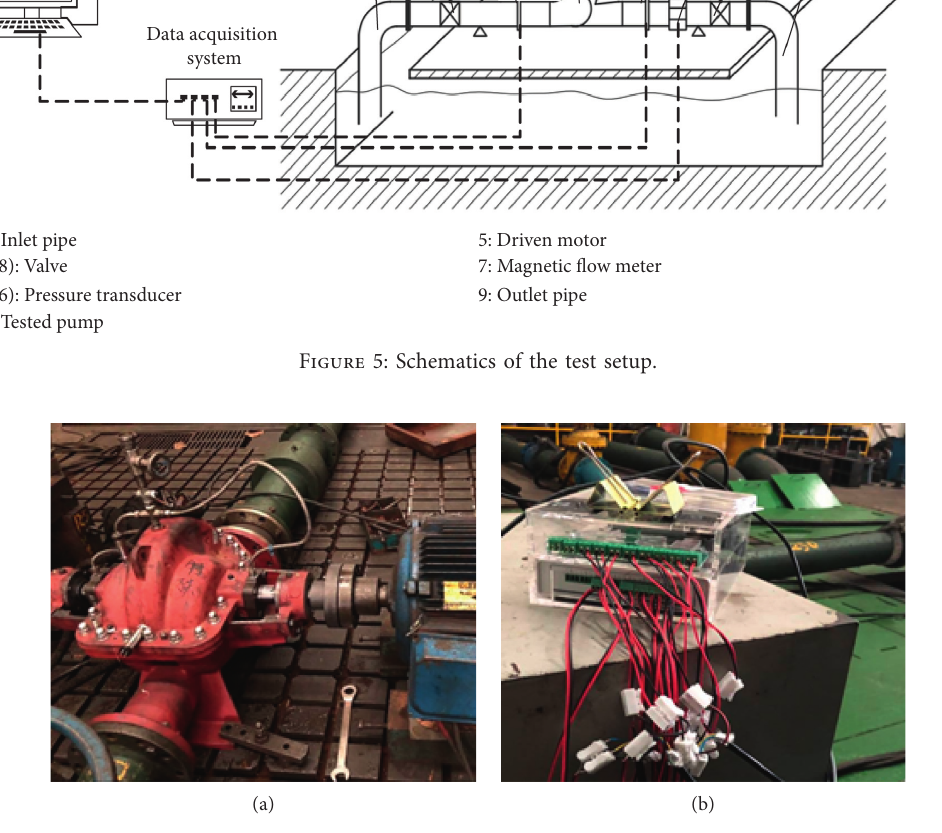
Figure 6: Test pump (a) and data acquisition device (b).